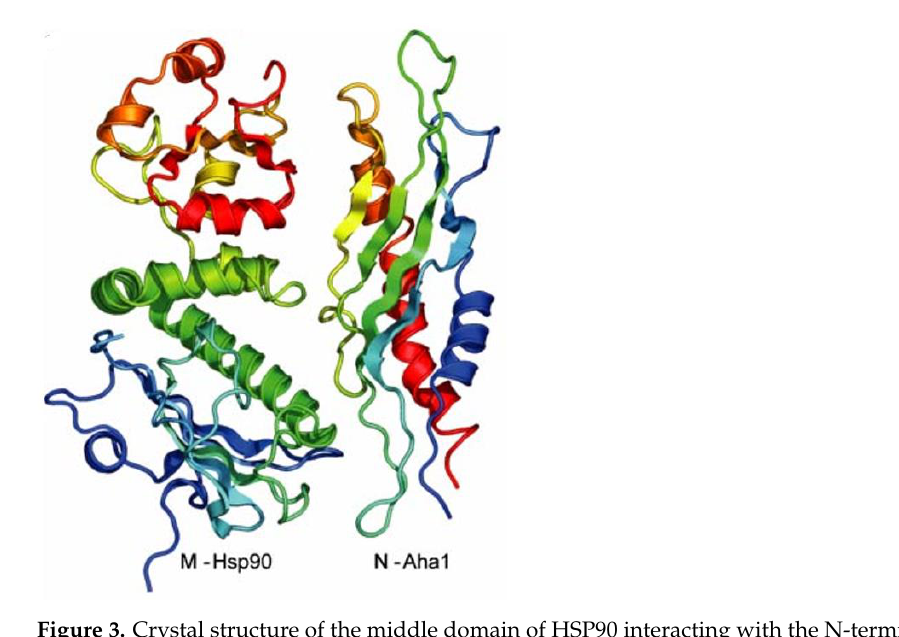
Figure 3. Crystal structure of the middle domain of HSP90 interacting with the N-terminal domain of Aha1 [65].